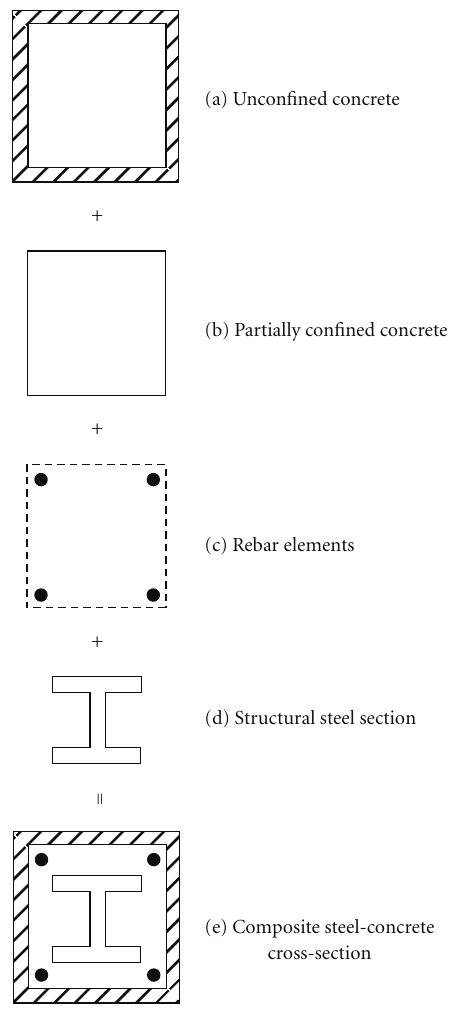
Figure 2: FEM of